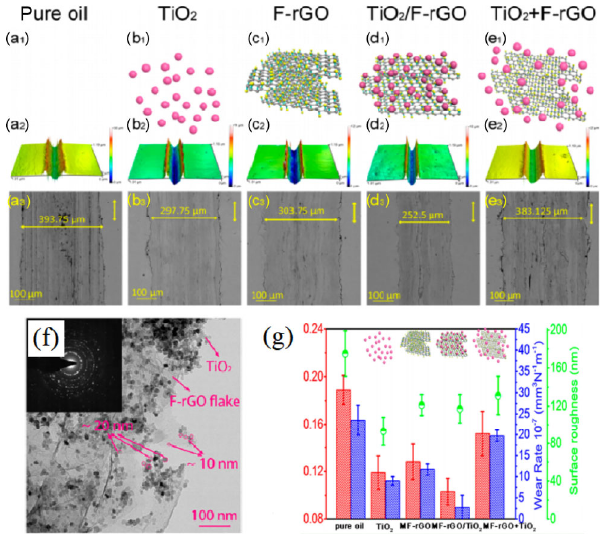
Fig. 11 (a 1 -e 1 ) Schematic diagram of different nanoadditives; (a 2 –e 2 ) Optical micrographs and (a 3 –e 3 ) SEM images of wear tracks lubricated with pure oil, TiO 2 nanoparticles, F-rGO nanosheets, TiO 2 /F-rGO nanocomposites, and a mixture of TiO 2 nanoparticles and F-rGO nanosheets; (f) TEM image of TiO 2 /F-rGO nanocomposites; (g) tribological results. Reproduced with permission from Ref. [196], © American Chemical Society